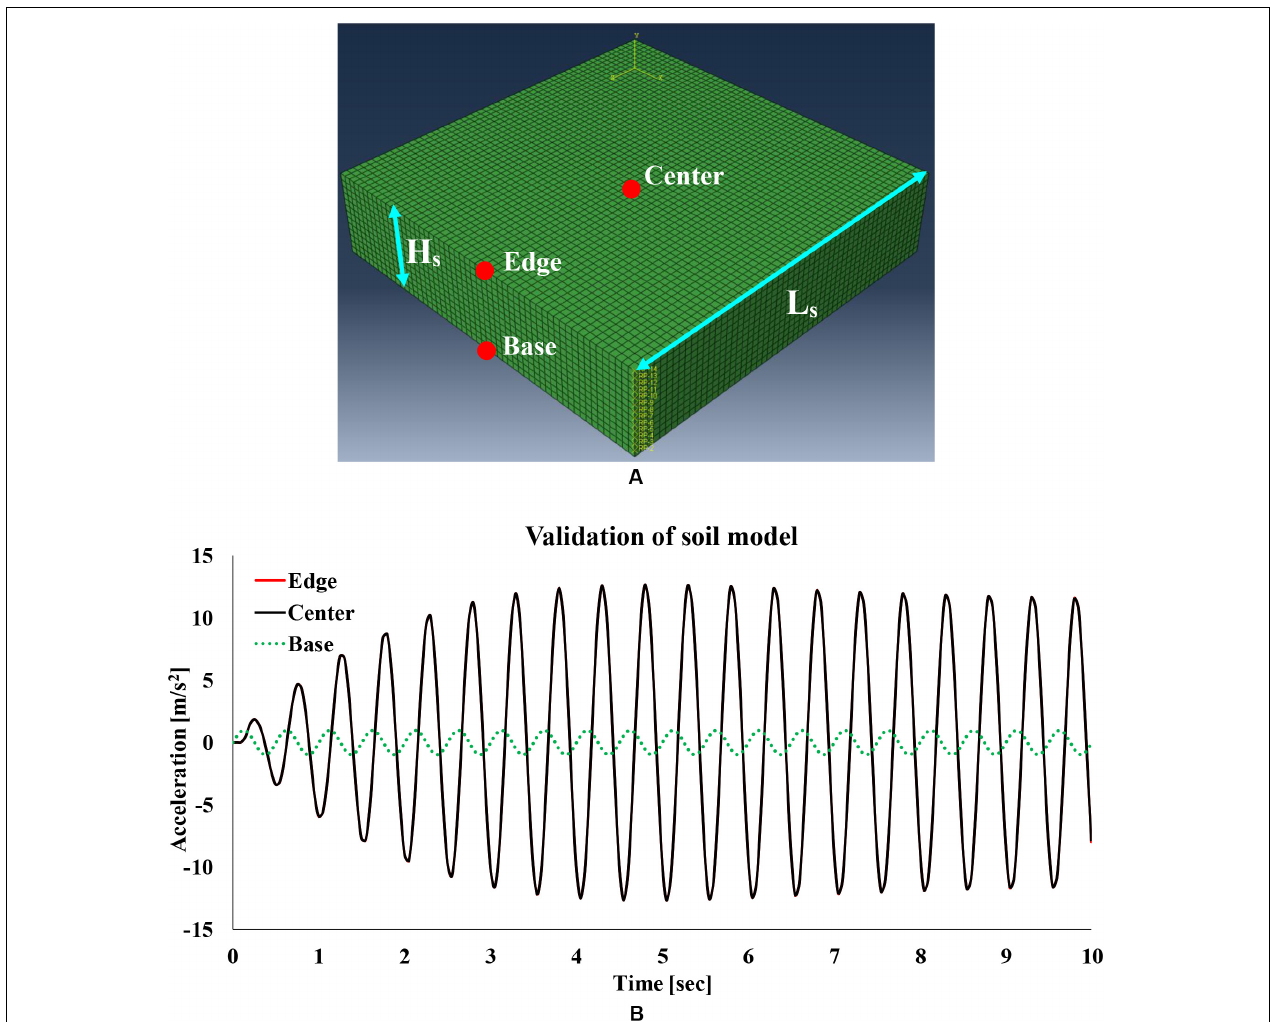
FIGURE 2 | (A) Validation model of soil layer dynamic response and (B) imposed harmonic excitation at the base and computed accelerations at the center and the edge of soil surface.